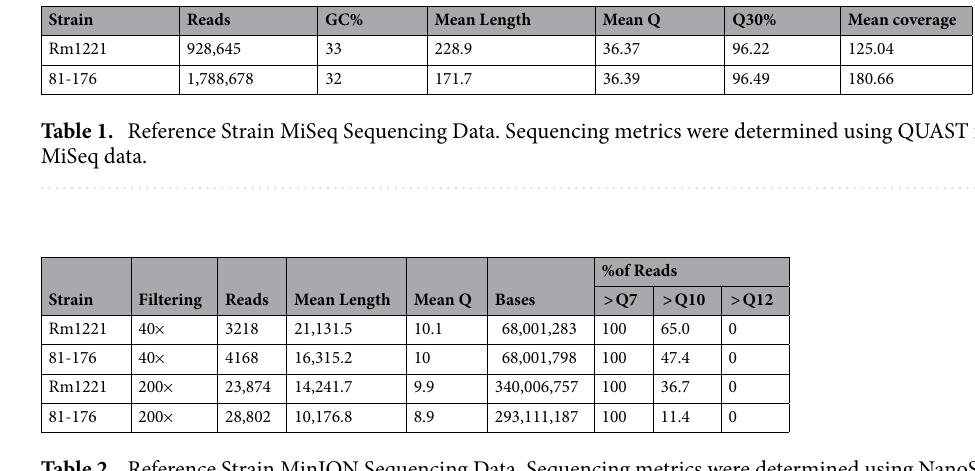
Table 2. Reference Strain MinION Sequencing Data. Sequencing metrics were determined using NanoStat for MinION data.